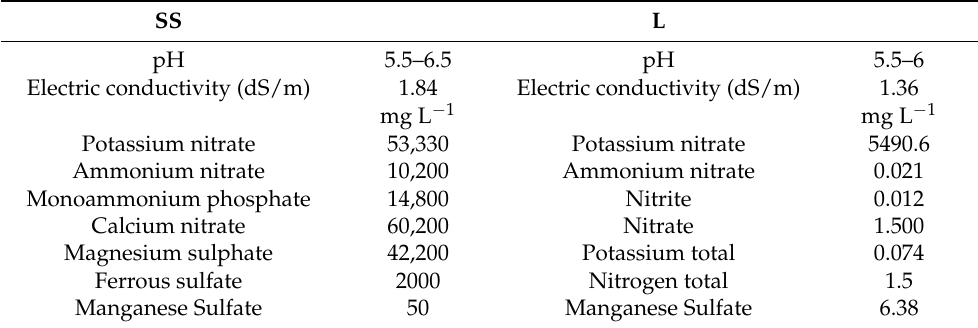
Table 1. Solution-component analyses of nutritional source for M. spicata and R. officinalis in hydro- ponic